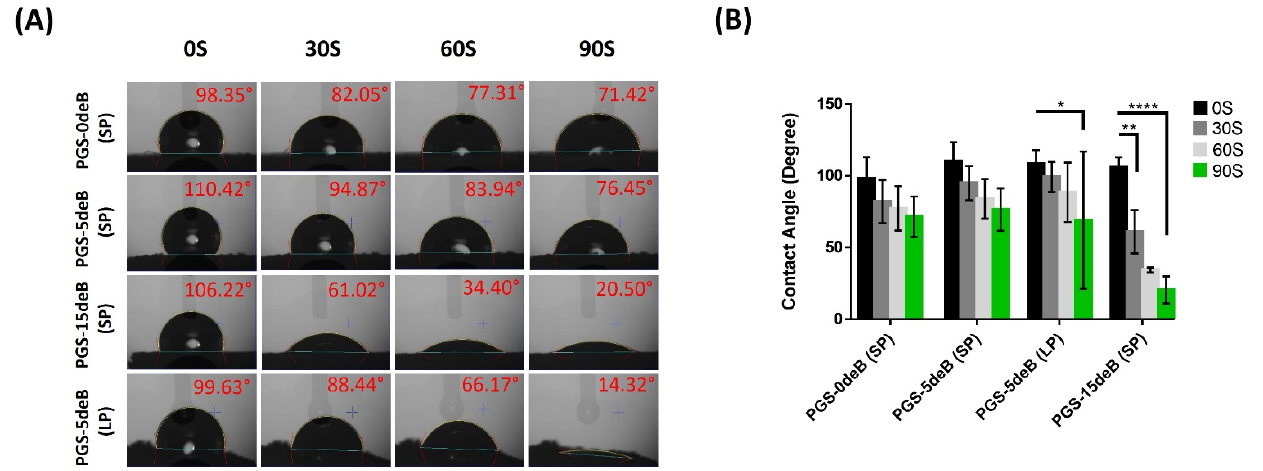
Figure 7. Hydrophilicity measurements of the PGS-deB and bone-free porous PGS scaffolds were taken at 0, 30, 60, and 90 s of dropping ddH 2 O onto the surface ( A ); the measured values are shown as mean ± standard deviation and * p < 0.05; ** p ≤ 0.01 and **** p < 0.0001 indicates statistical significance ( n = 4) ( B